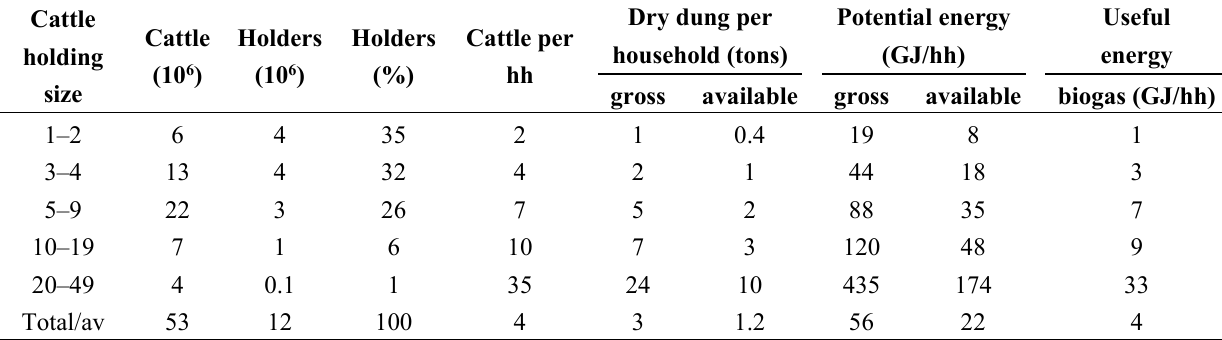
Table 6. Households (hh) annual energy production potential from cow